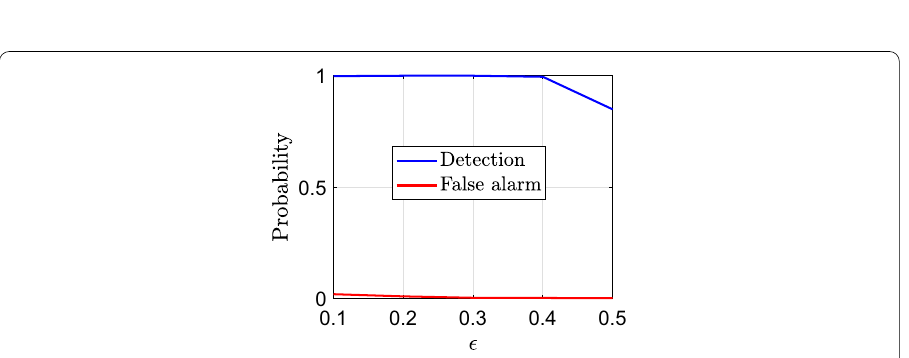
Fig. 7 The weights in the robust method can be used to classify samples C ( z ) ∈ { 0,1 } as ‘normal’ or ‘corrupted’. This yields probabilities of correct detection Pr